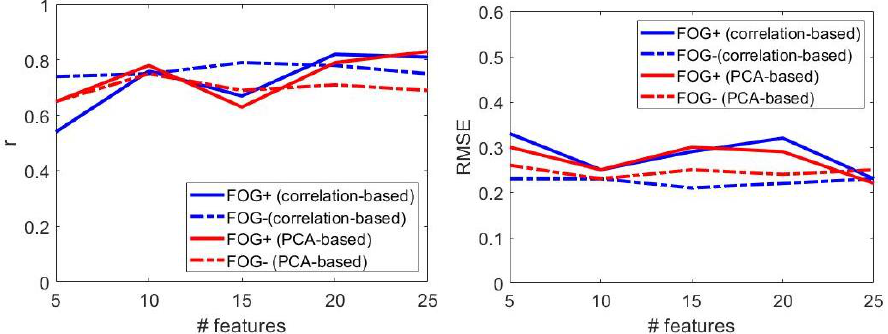
Figure 10. The effect of freezing of gait on the regression model performance, in terms of correla- tion coefficient ( left ) and root mean square error ( right ). Performance refers to patients not under dopaminergic therapy. FOG+: patients with freezing of gait; FOG − : patients without freezing of